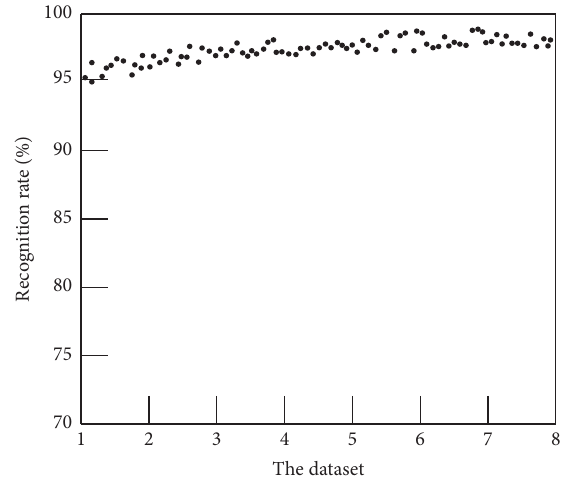
Figure 2: Changes in the recognition rate of the proposed method.